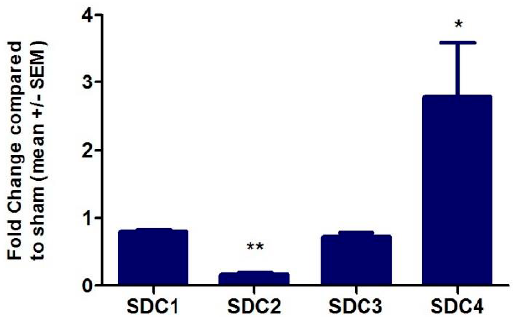
Figure 1. Fold-changes of SDC transcription in HMVECs (relative to glyceraldehyde 3-phosphate dehydrogenase (GAPDH) expression) following total RNA extraction after TNF α stimulation for 4 h, ( n = 3; for further details see Materials and Methods). Statistical analysis by Student’s t -test: * p -value < 0.05; ** p -value < 0.005.